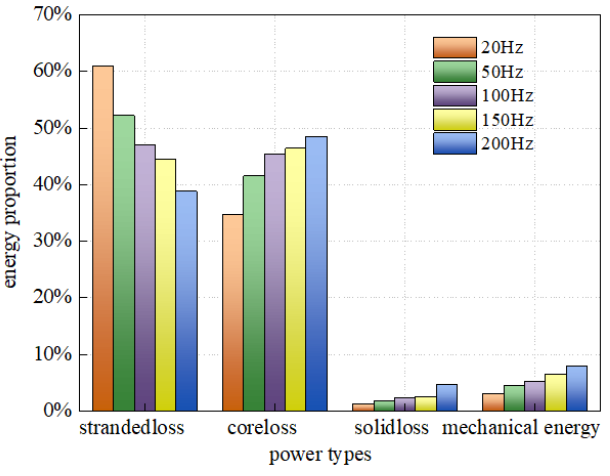
Figure 10. Power proportion in PECA.